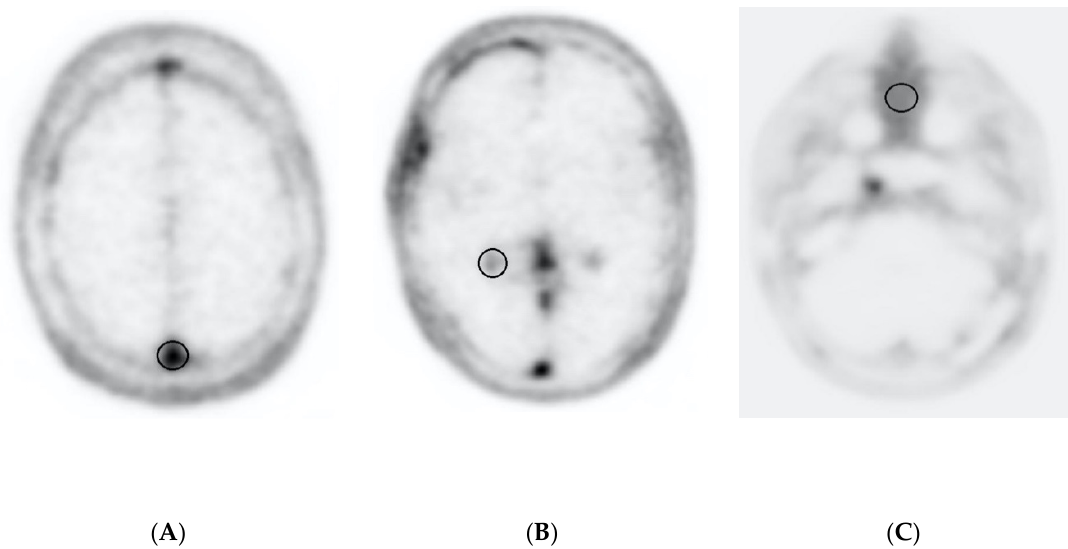
Figure 2. Background, region of interest. ( A ) Sagittal sinus, measured in the posterior part of the venous superior sagittal sinus; ( B ) choroid plexus, measured in the posterior horn of the right-side ventricle; ( C ) nasal mucosa.